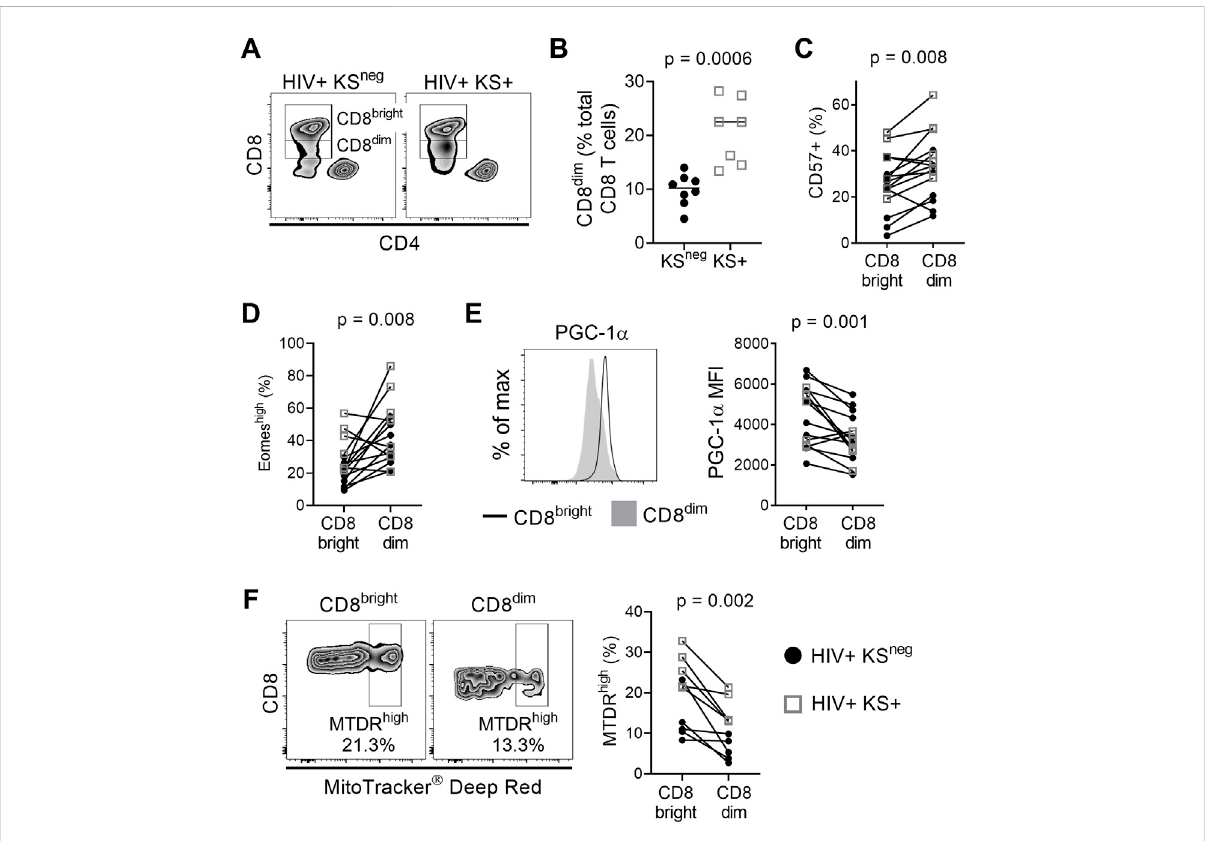
FIGURE 1 CD8 dim T cells with low mitochondrial activity are expanded in individuals with persistent KS. (A) Representative plots showing CD8 bright and CD8 dim T cells in a HIV+ KS neg and a HIV+ KS+ participant. (B) The frequency of CD8 dim T cells (as a percentage of total CD8 T cells) is signi fi cantly elevated inHIV+ individuals withpersistentKS underART(KS+; n =7)comparedwith theKS neg group( n =8)(differenceofmedians=12.28%;Mann- Whitney test). (C) A signi fi cantly higher percentageof CD8 dim Tcells express CD57 compared with CD8 bright Tcells (median of differences = 8%; Wilcoxon signed-rank test). (D) A signi fi cantly higher percentage of CD8 dim T cells express Eomes compared with CD8 bright T cells (median of differences = 13.5%; Wilcoxon signed-rank test). (E) Expression of the mitochondrial master regulator PGC-1 α is signi fi cantly reduced in CD8 dim T cells (median of differences = − 789 MFI; Wilcoxon signed-rank test). (F) The frequency of MitoTracker DeepRed high cells issigni fi cantly lower for CD8 dim T cells compared with CD8 bright T cells (median of differences = − 8.99%; Wilcoxon signed-rank test). Gray open squares, HIV+ KS+ participants; black circles, HIV+ KS neg